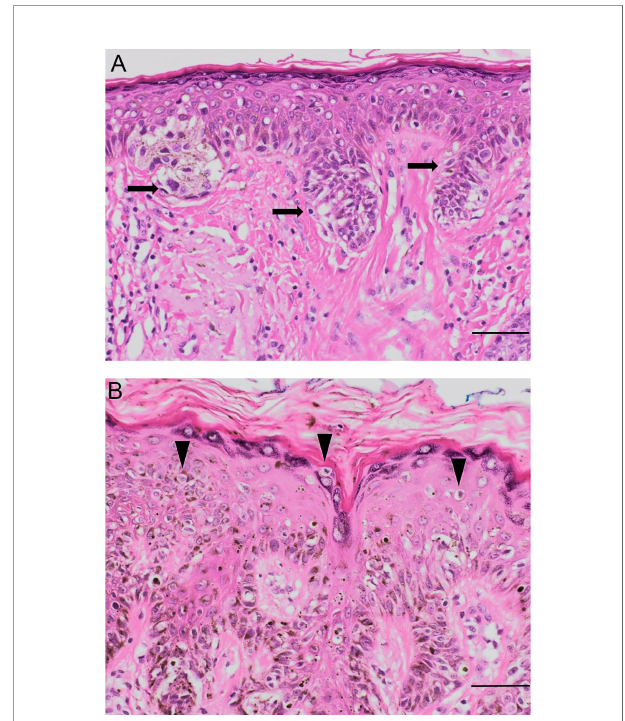
FIGURE 4 | Pathological evidence of EMU disruption. (A) Dysplastic junctional naevus with nests and junctional mildly atypical melanocytes at the dermo-epidermal junction (black arrows). (B) Melanoma in situ with large melanocytes spreading upwards into the epidermis (arrowheads). Original magni fi cation 50 m m, hematoxylin-eosin